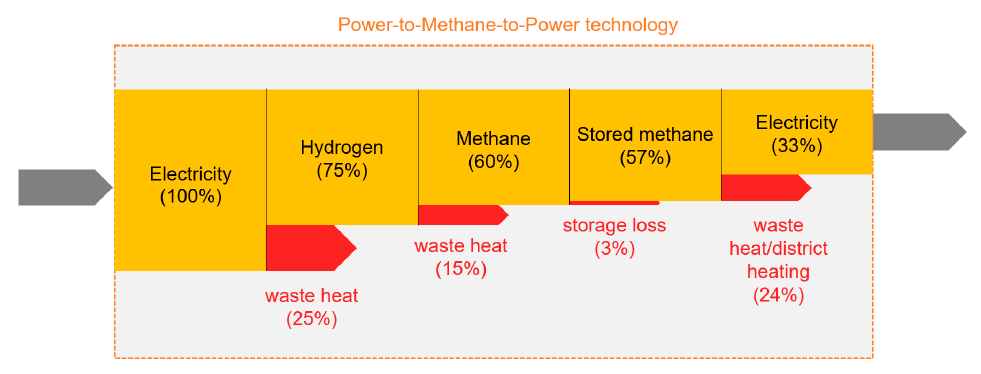
Figure 4. The steps of the Power-to-Methane-to-Power cycle; efficiencies and dissipative losses are marked.